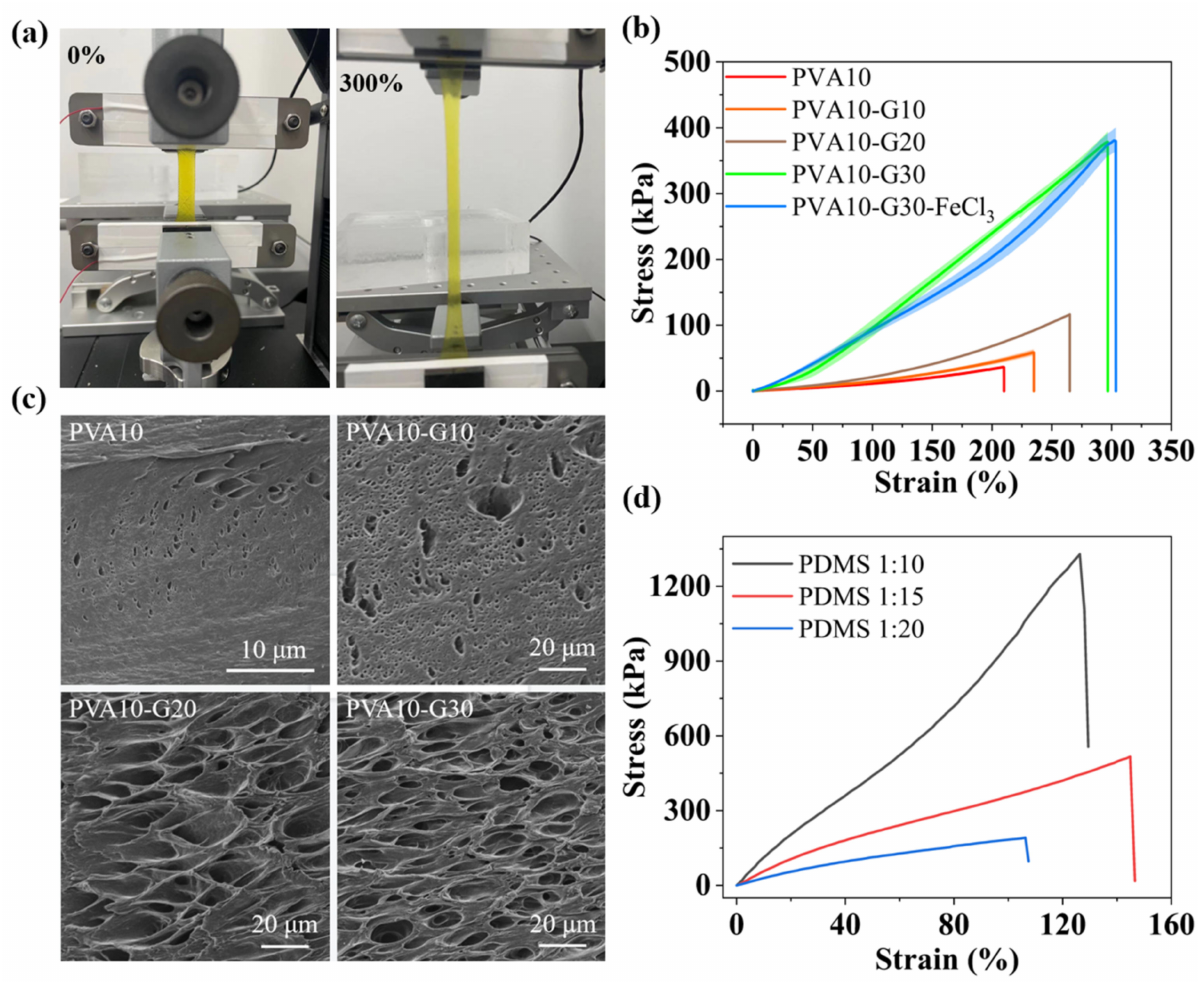
Figure 5. ( a ) Photos of the original PVA10-G30-FeCl 3 hydrogel and the hydrogel after being stretched to 300% strain. ( b ) Comparison of the stress-strain curve of PVA10, PVA10-Gn, and PVA10-G30-FeCl 3 hydrogels. ( c ) SEM image for freeze-dried PVA10 and PVA10-Gn hydrogels. ( d ) Comparison of the stress-strain curve of PDMS with the ratio of crosslinker to the monomer of 1:10, 1:15, and